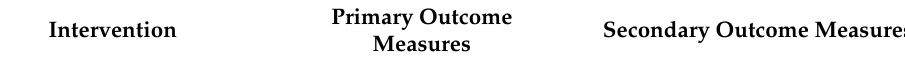
Table 1. A summary of ongoing clinical drug trials for the treatment of progressive multiple sclerosis. (Website: https://www.clinicaltrials.gov/; accessed on 12 April